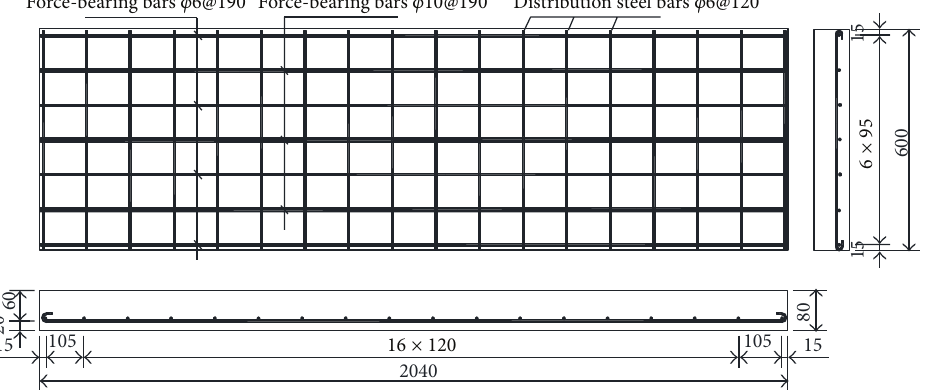
Figure 6: Construction drawing of the ordinary RC